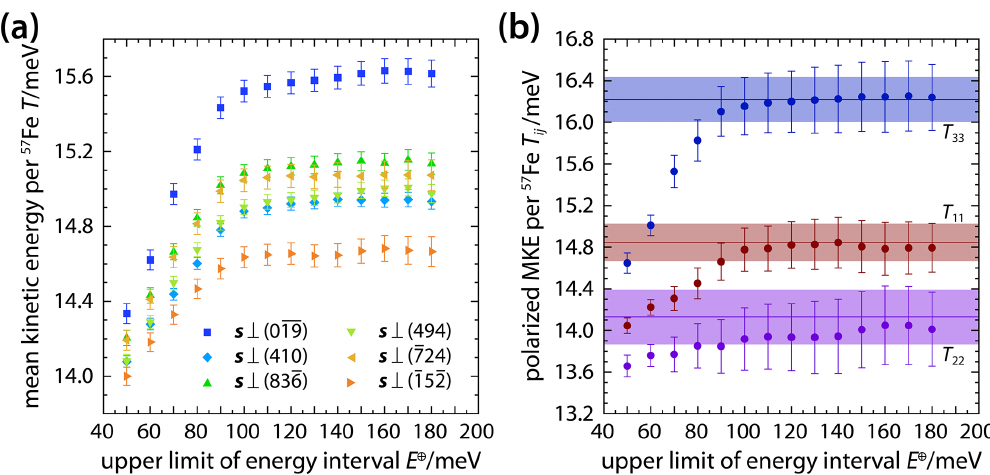
Figure 5. Mean kinetic energies per vibrational mode and per 57 Fe atom in δ -(Al,Fe)OOH single crystals. Mean kinetic energies (a) were derived from NRIXS spectra recorded with the X-ray beam incident along different directions s and by stepwise increasing the analyzed energy interval. The anisotropy of the mean kinetic energy (MKE) can be described using a second-rank tensor with the components T 11 , T 22 , and T 33 (b) that can be obtained by inverting (solid circles) the observed mean kinetic energies (shown in a ) or by integrating (horizontal lines) the components of the polarized PDOS (Fig. 2b). Shaded areas indicate